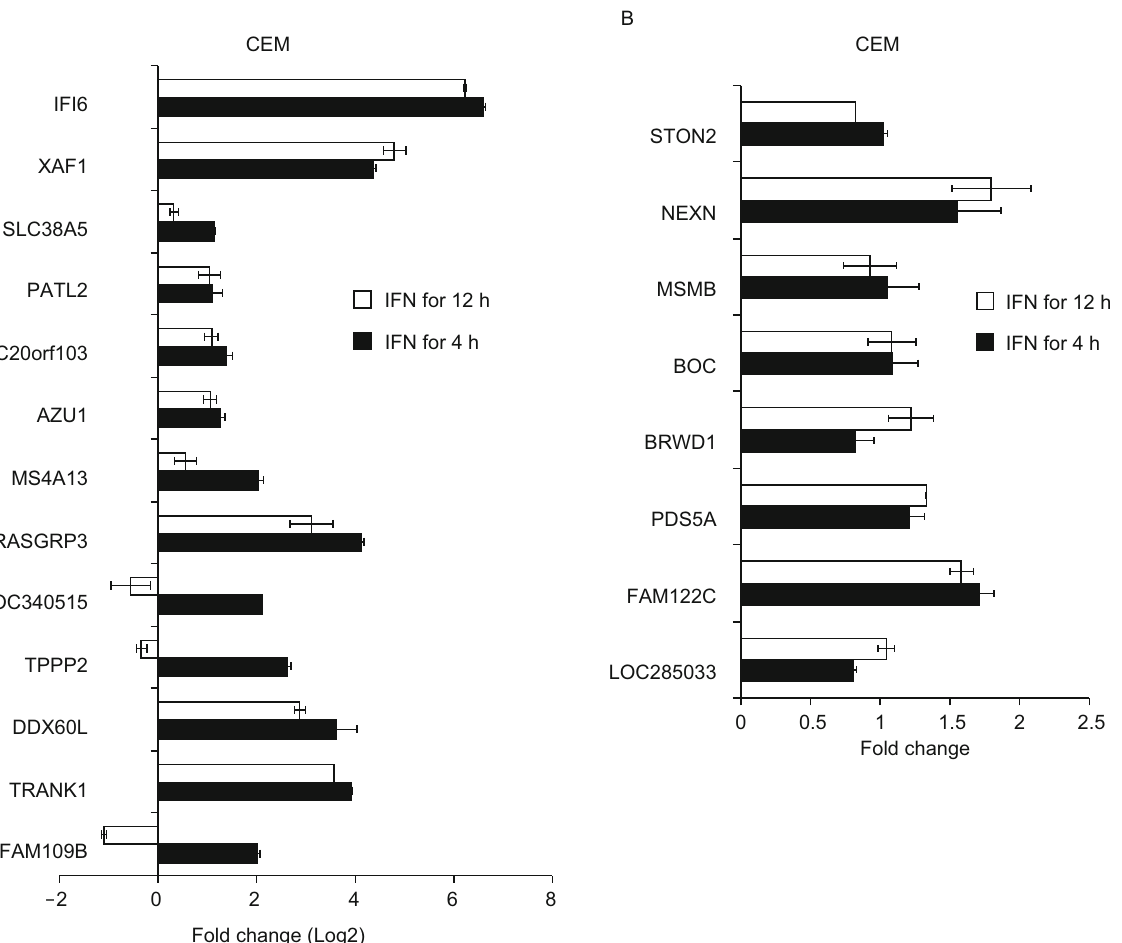
Figure 2. Validation of new ISG candidates in CEM cells by qRT-PCR. CEM cells were treated with Con-IFN for 0 h, 4 h or 12 h. The mRNA levels of the ISG candidates were analyzed by qRT-PCR. The ISG candidate mRNA levels were normalized with GAPDH levels. IFI6 and XAF1, two known ISGs, were used as positive controls. Fold change was calculated as the mRNA level in the cells with Con-IFN treatment divided by that without treatment. Data represented are mean ± SD of two independent